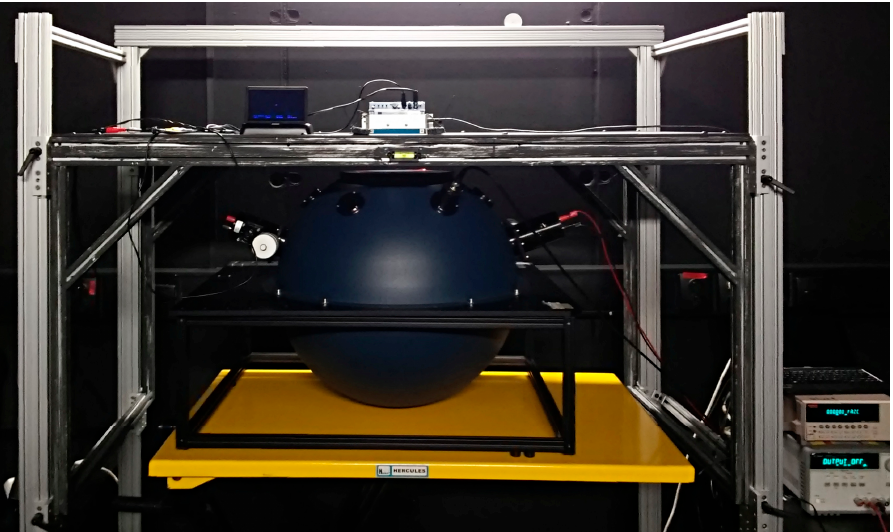
Figure 3. CSTM-LR-20-M integrating sphere with mounted multispectral camera above in the dark room.